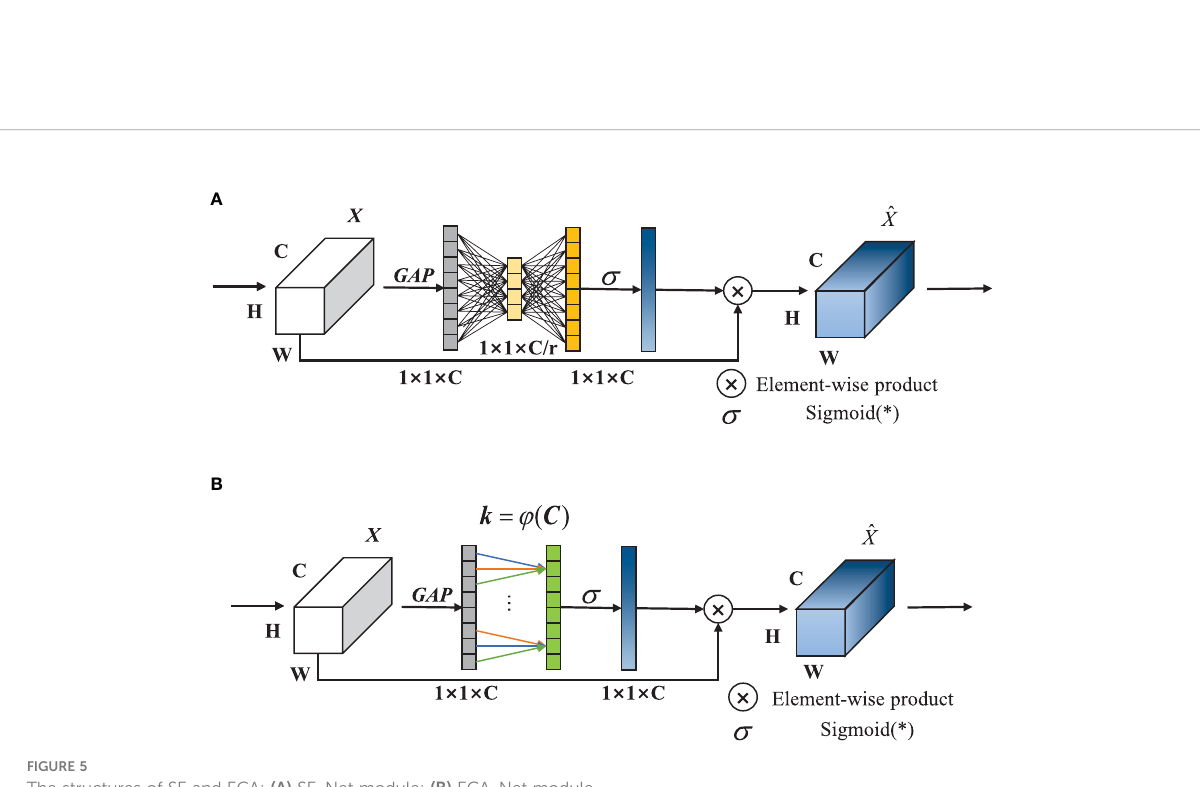
FIGURE 5 The structures of SE and ECA: (A) SE-Net module; (B) ECA-Net